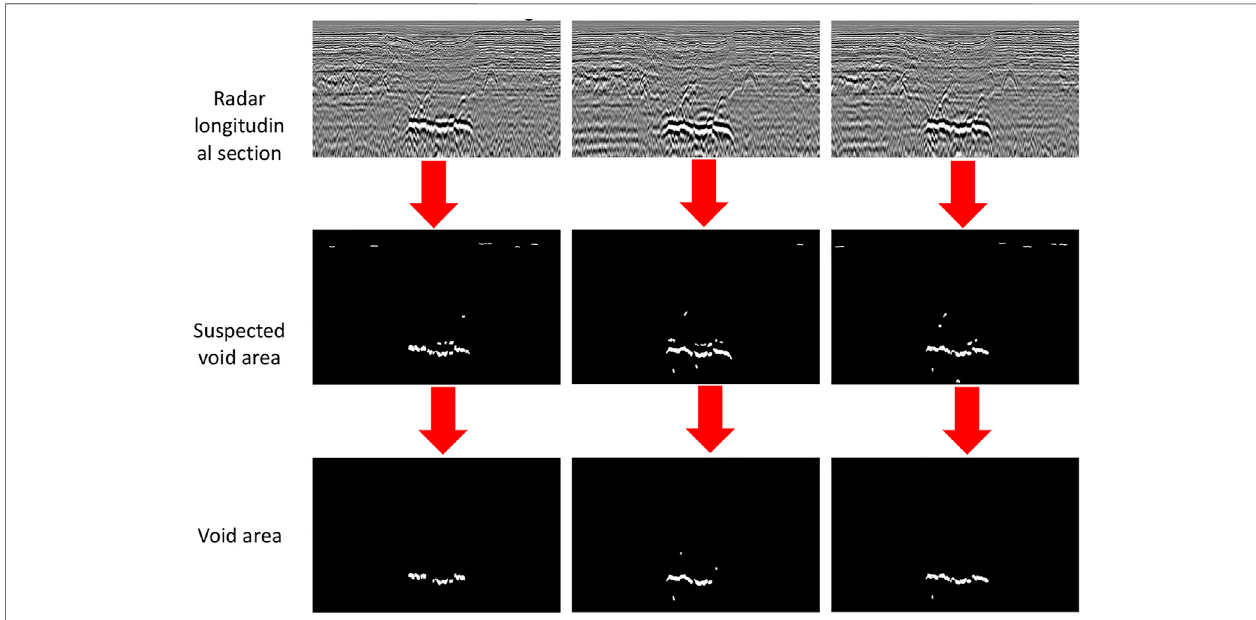
FIGURE 8 | Determination of the suspected void area in the adjacent longitudinal section diagram.